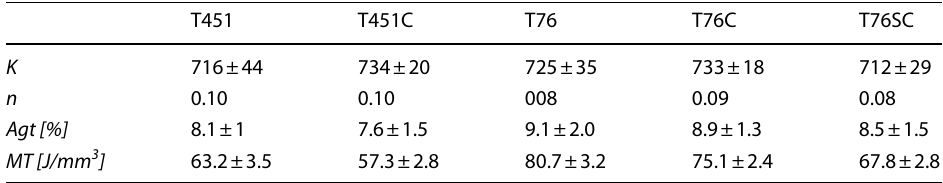
Table 3 Tensile test parameters for the different examined